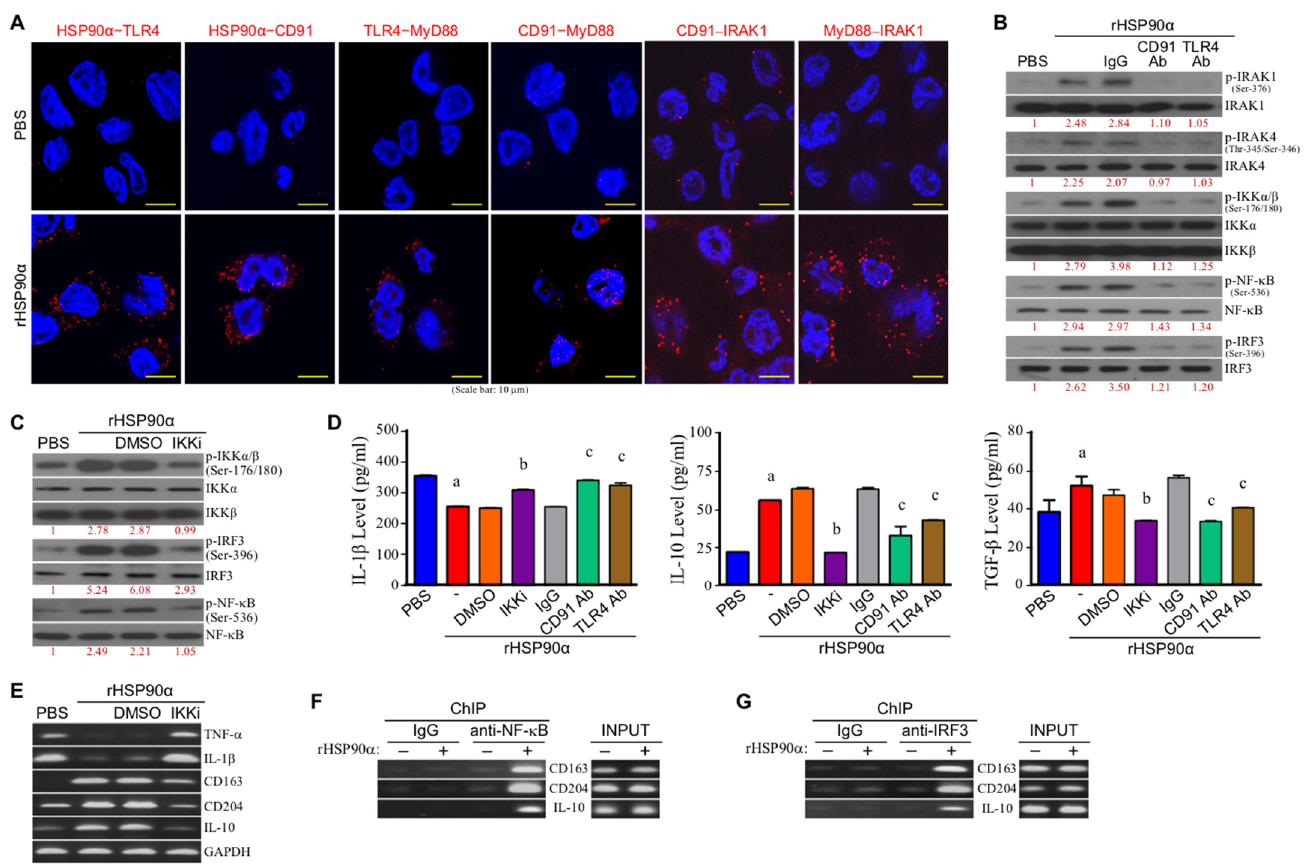
Figure 2. The canonical CD91/MyD88–IRAK1/4–IKK α / β –NF- κ B/IRF3 signaling pathway is in- volved in eHSP90 α -induced macrophage M2-polarization. ( A ) Red fluorescent dots in PLAs showed that the physical associations of HSP90 α –TLR4, HSP90 α –CD91, TLR4–MyD88, CD91–MyD88, CD91– IRAK1, and MyD88–IRAK1 were induced when THP-1-derived macrophages were treated for 4 h with 15 µ g/mL of rHSP90 α . The representative data of three independent experiments are shown. ( B ) Levels of IRAK1, phosphorylated IRAK1, IRAK4, phosphorylated IRAK4, IKK α , IKK β , phospho- rylated IKK α / β , NF- κ B, phosphorylated NF- κ B, IRF3, and phosphorylated IRF3 in the THP-1-derived macrophages treated with PBS, rHSP90 α , or rHSP90 α plus control IgG or anti-CD91 or TLR4